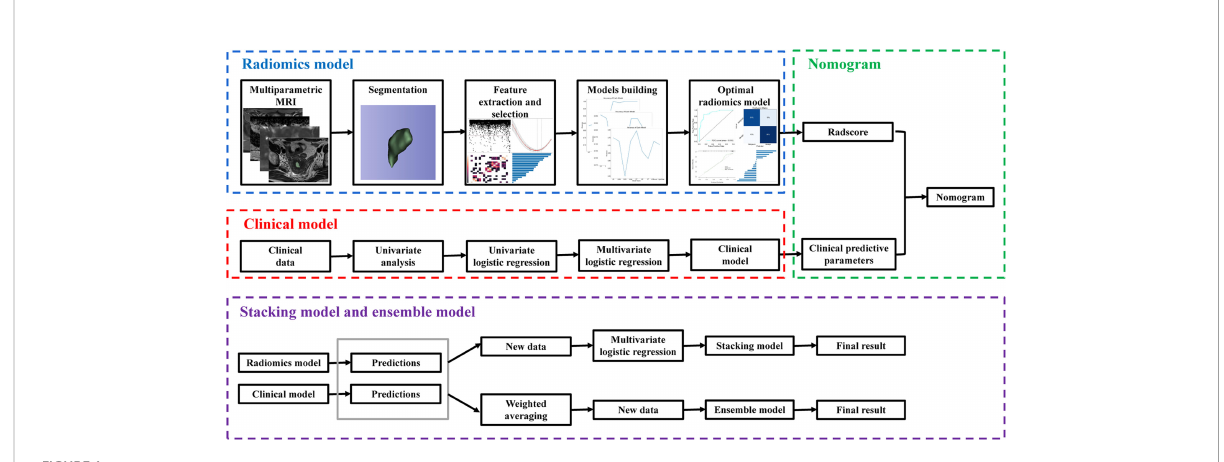
FIGURE 1 The overall work fl ow of this